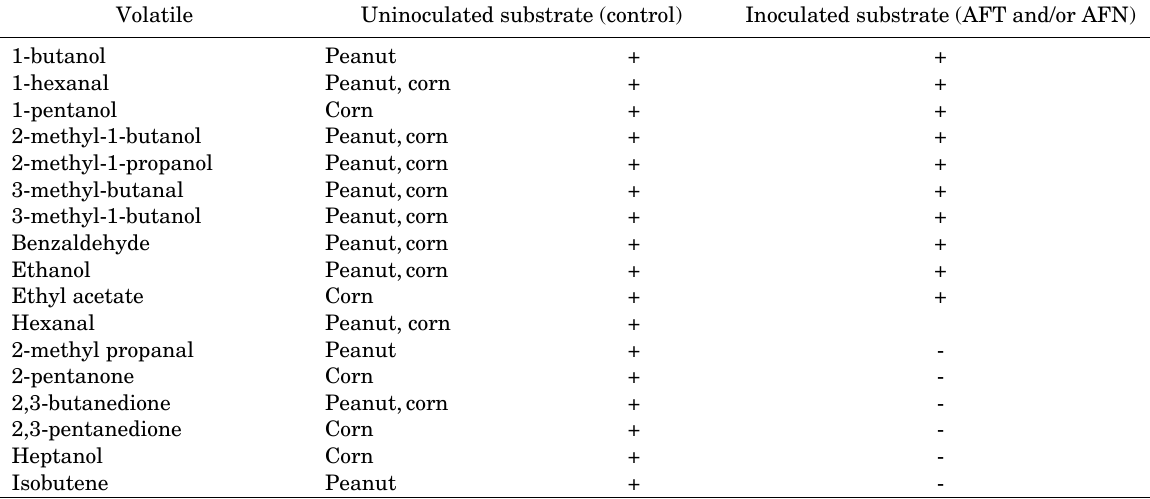
Table 2. MVOCs in headspace gases associated with uninoculated peanut and uninoculated corn substrate only, or also associated with AFT and AFN